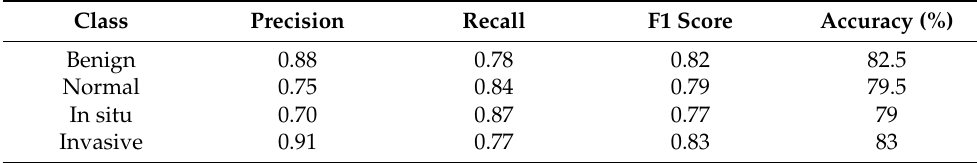
Table 4. Results of the patch-level classification of the 4-class classification